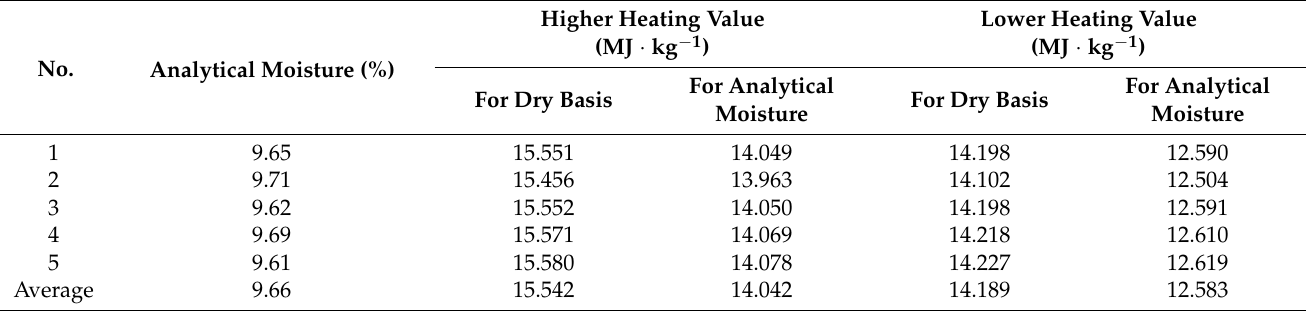
Table 4. Test results of higher heating value and lower heating value of post-flotation dairy